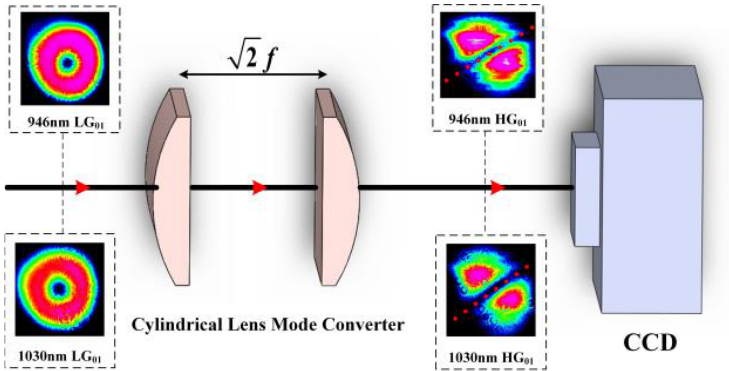
Figure 7. The schematic diagram of the output laser mode and the measurement results. Further, we carried out experiments and concluded the relationship between the power of the 946 and 1030 nm LG 01 mode vortex lasers and the pump power of the annular beam, respectively, and the results are shown in Figure 8. When the pump power of the annular beam is 9.7 W, the 946 nm LG 01 mode vortex laser comes to the start of the output; When the pump power of the annular beam is increased to 11.9 W, the 946 and 1030 nm LG 01 mode vortex laser start to output simultaneously. When the pump power of the annular beam is increased to 16.1 W, the output power of the 946 and 1030 nm LG 01 mode vortex laser is consistent, and their size is 0.277 W; When the pump power of the annular beam is 20 W, the output power of 946 and 1030 nm LG 01 mode vortex lasers is 0.404 and 0.510 W, while the corresponding slope efficiency is 3.6% and 6.2% respectively. The total optical-optical conversion efficiency is 4.6%. Since the full mirror M 3 and Yb:YAG crystal will bring losses to the 946 nm laser oscillation, this is one of the reasons for the lower output power and slope efficiency of the 946 nm LG 01 mode laser. Another reason is that the dual-wavelength vortex laser is output only in a single handedness, and the laser with opposite handedness is